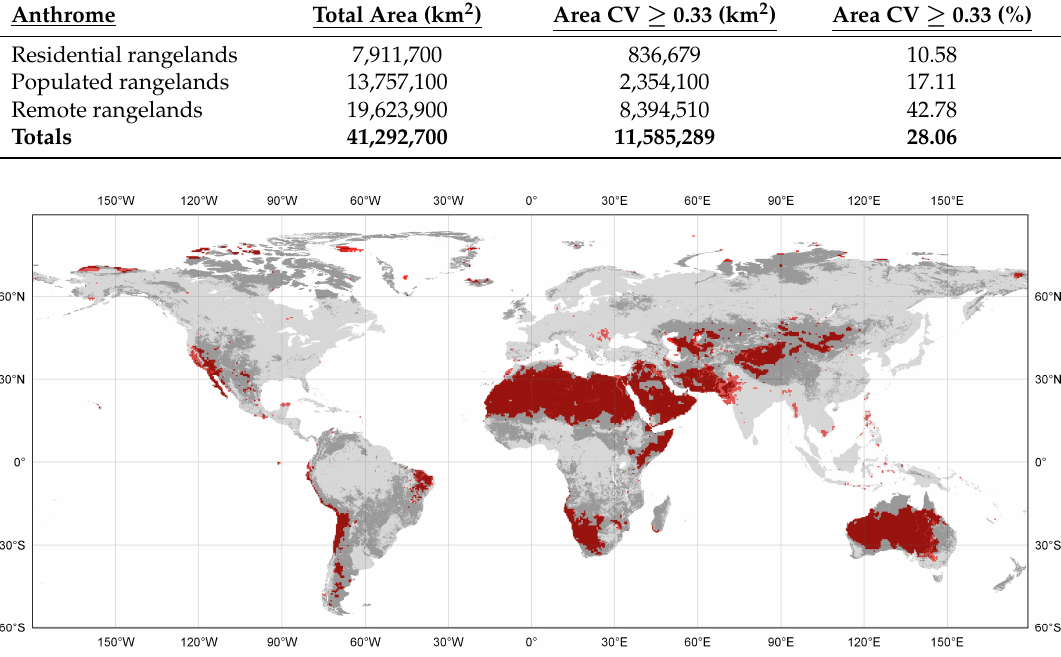
Figure 1. Map of global land area with an inter-annual precipitation coefficient of variation ≥ 33% (red), based on data from 1970 through 1999 (University of Delaware global gridded monthly precipitation dataset (http://www.esrl.noaa.gov/psd/)). Greyed background indicates rangeland and